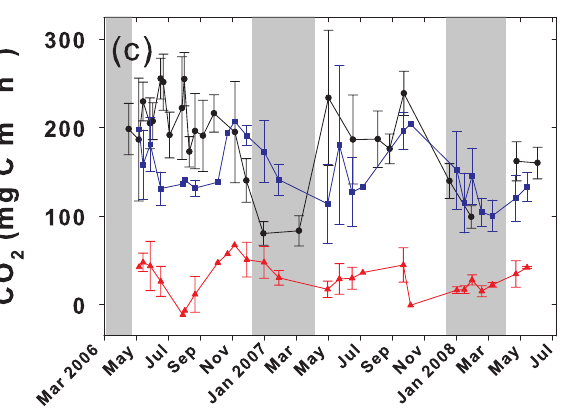
Figure 4. Mean (± SE, n = 3) modeled soil CO a) fluxes and b) production rates with soil 2 depth as well as c) time series of measured ( ─, •) and modeled soil CO efflux. CO fluxes 2 2 Fig. 4. Mean ( ± SE, n =3) modeled soil CO 2 (a) fluxes and (b) pro- duction rates with soil depth as well as (c) time series of measured and production were calculated with the soil-CO profile method, using the physically 850 2 ( – , • ) and modeled soil CO 2 efflux. CO 2 fluxes and production modeled diffusion coefficients D (black line in Fig. 3a and b) with a sigmoidal ( ─, ▲ ) or were calculated with the soil-CO 2 profile method, using the physi- cally modeled diffusion coefficients D (black line in Fig. 3a and b) exponential ( ─, ■ ) function to interpolate between the measured CO concentrations. Grey with a sigmoidal ( – , ) function to interpo- 2 late between the measured CO 2 concentrations. Grey shadings in shadings in c) mark the dry seasons. (c) mark the dry 31